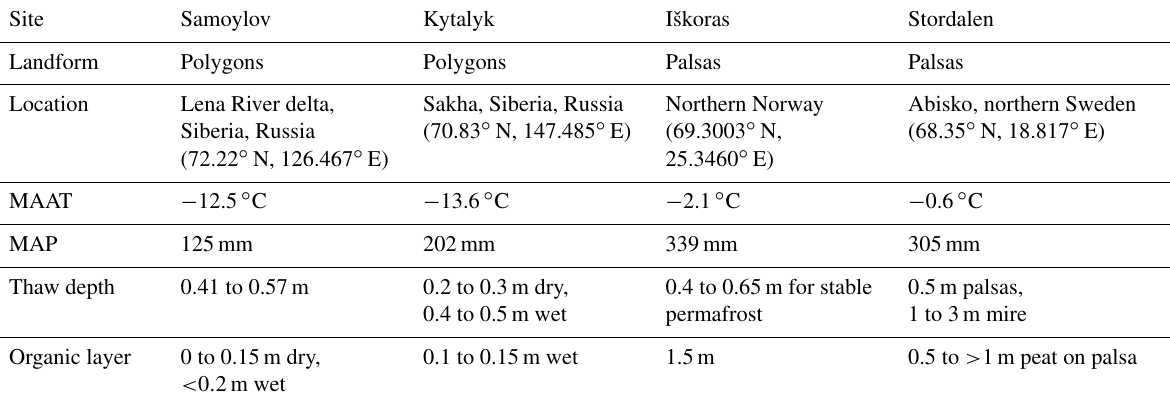
Table 1. Summary of sites. Further details and sources can be found in Table A1 (Appendix A). MAAT stands for mean annual air tempera- ture, and MAP stands for mean annual